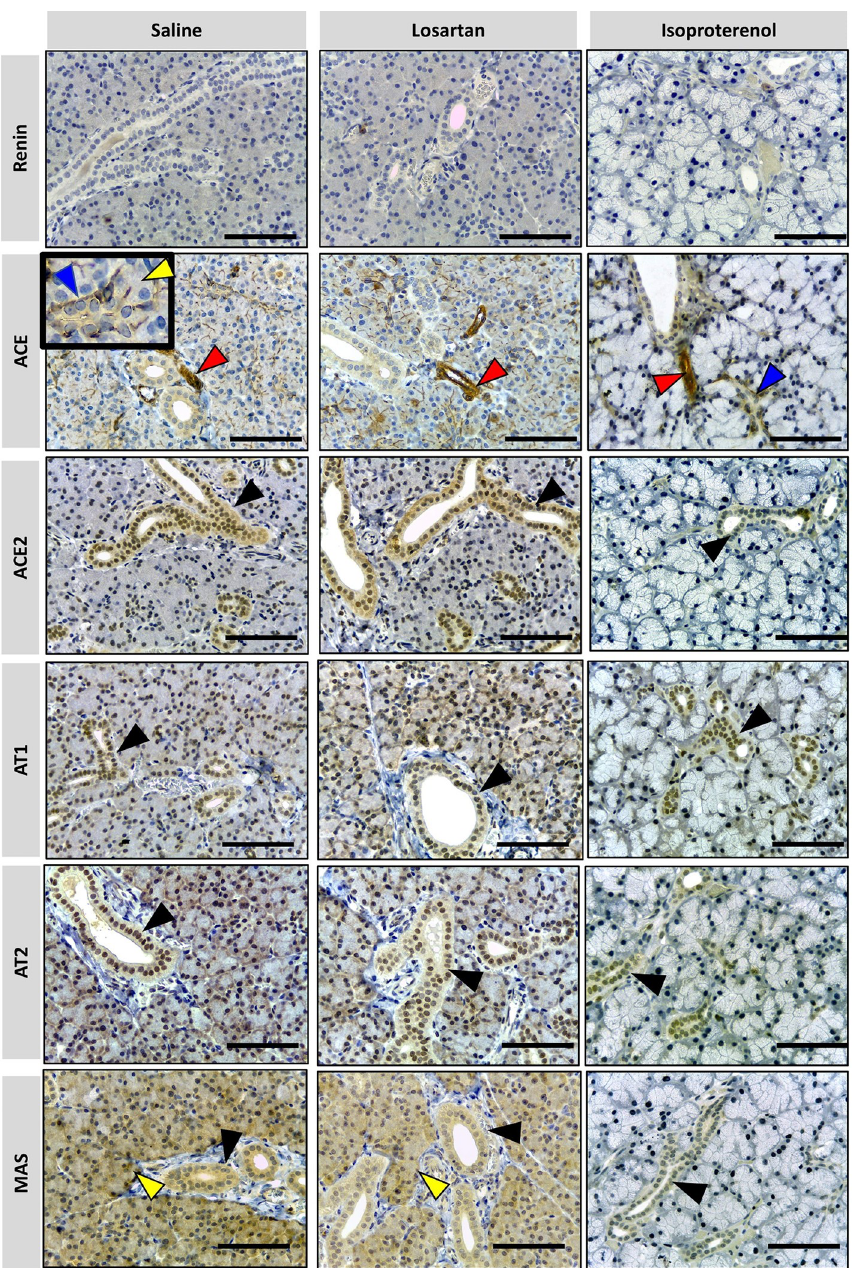
Fig 4. Photomicrographs of immunohistochemical staining (brown) of RAS targets in rat parotid gland. Targets: REN, ACE, ACE-2, AT1, AT2 and MAS were analyzed. Arrows indicated by colors: blue = ducts; yellow = acini; red = blood vessels; black = epithelial cells of the duct system. No REN expression in parotid glands was observed under all treatments. ACE is present in myoepithelial cells around intercalated ducts (indicated by blue arrowhead in detail), acini (indicated by yellow arrowhead in detail) and in blood vessels (indicated by red arrowhead). ACE-2, AT1 and AT2 are present in epithelial cells of the duct system (indicated by black arrowhead), while MAS is present in duct cells (black arrowhead) and acinar cells (blue arrowhead) in all treatments except for isoproterenol. Comparatively, the parotid glands of the animals which received saline and losartan show a similar pattern of immunolabeling for RAS targets but have more expression than in animals which received isoproterenol. (x40 objective and scale bar = 50 μ m).